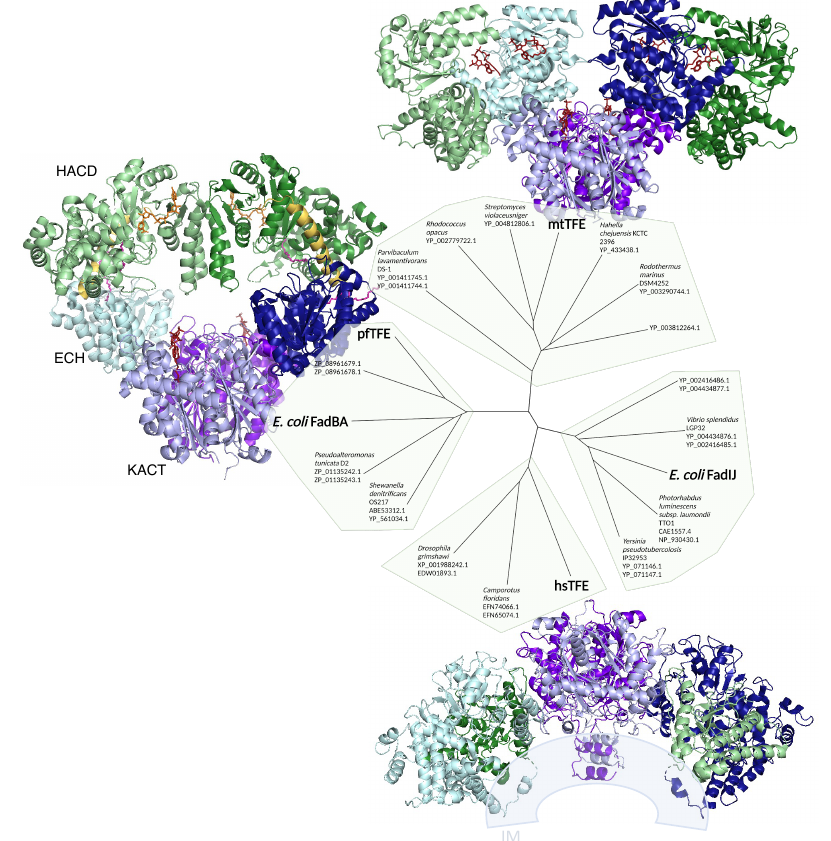
IM Figure 4. TFE complex families. TFE-a and TFE-b sequences have been proposed to group in four Figure 4. TFE complex families. The clustering of TFE sequences into four subfamilies is taken parallel subfamilies [24]. We are showing the pairs of TFE-a and TFE-b proteins in global families, from [24]. The organisms for which the 3D structure of the TFE complexes have been determined indicated by the light shading on a phylogenetic tree widely simplified from [24]. The organisms are shown in bold letters. pfTFE = Pseudomonas fragi [23]; hsTFE = Homo sapiens [25]; mtTFE = Mycobacterium tuberculosis [24] . The quaternary assembly of mtTFE, pfTFE, and mitochondrial for which the 3D structure of the TFE complexes have been studied are shown in bold letters. hsTFE are shown anticlockwise from the top. The two TFEα ECH domains are shown in blue (light and dark), the two TFEα HACD domains are shown in green (light and dark). The TFEβ dimer pfTFE = Pseudomonas fragi (PDB code: 1WDK) [23]; hsTFE = Homo sapiens (PDB code: 5ZQZ) [25]; (KACT domain) is at the center in violet (light and dark). Acyl-CoA are shown in red sticks. In the mtTFE = Mycobacterium tuberculosis (PDB code: 4B3J) [24]. The quaternary assemblies of mtTFE, structure of pfTFE, the two α-helices linker are shown in yellow, the NAD cofactors are shown in orange sticks, and the FA tail analogues in the TFEα are shown in pink. Predicted interaction of the pfTFE, and mitochondrial hsTFE are shown anticlockwise from the top. The two TFE α ECH domains hsTFE with the mitochondrial inner membrane (IM) is shown as suggested in [28]. are shown in blue (light and dark); the two TFE α HACD domains are shown in green (light and dark). The TFE β dimer (KACT domain) is at the center in violet (light and dark). Acyl-CoA is shown as red sticks. In the structure of pfTFE, the two α -helices linkers are shown in yellow, the NAD cofactors are shown as orange sticks, and the FA tail analogues in the TFE α are shown in pink. Predicted interaction of the hsTFE with the mitochondrial inner membrane (IM) is shown as suggested in